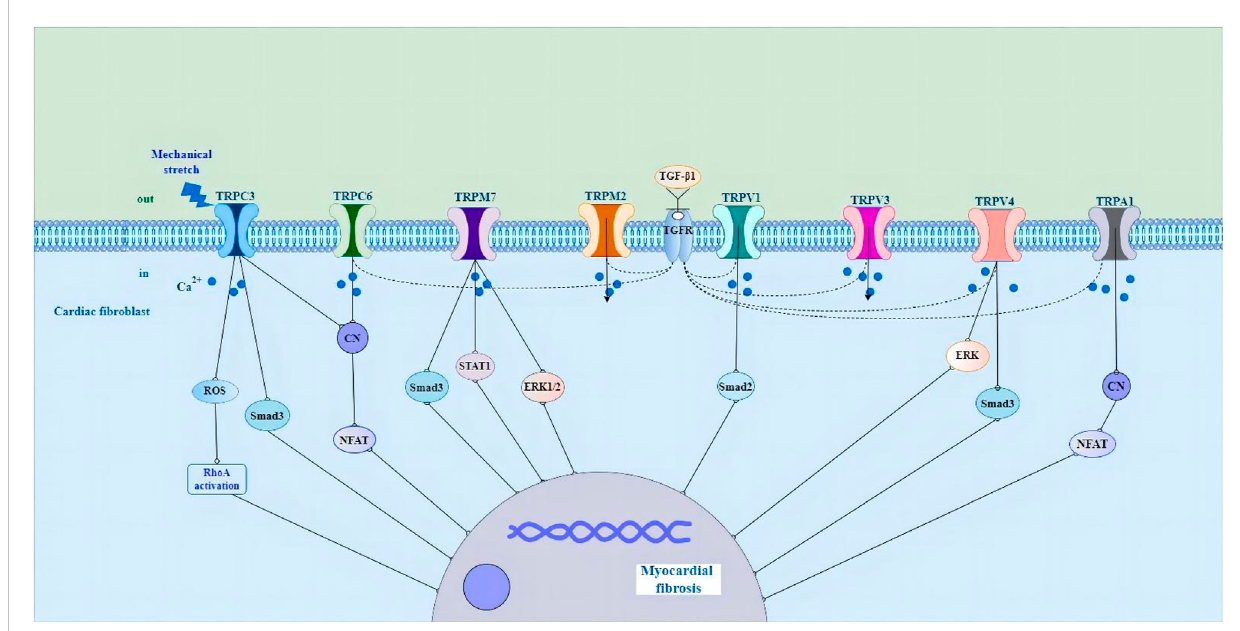
FIGURE 1 Schematic representation of the potential molecular mechanisms of TRP channels in cardiac fi broblasts in the pathological process of myocardial fi brosis. Abbreviations; TRP, transient receptor potential; ROS, reactive oxygen species; RhoA, Rho-associated kinase; CN, calcineurin; NFAT, nuclear factorofactivatedTcells;STAT1,signaltransducerandactivatoroftranscription1;ERK1/2,extracellularsignal-regulatedkinase1/2;TGF- β 1,growthfactor beta1; TGFR, growth factor receptor; ERK, extracellular signal-regulated kinase; See text for